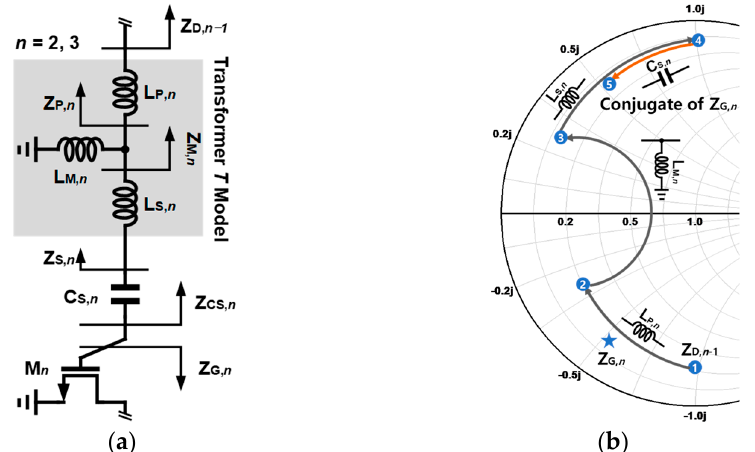
Figure 6. Conjugate matching for inter-stage: ( a ) schematic and ( b ) Smith chart.